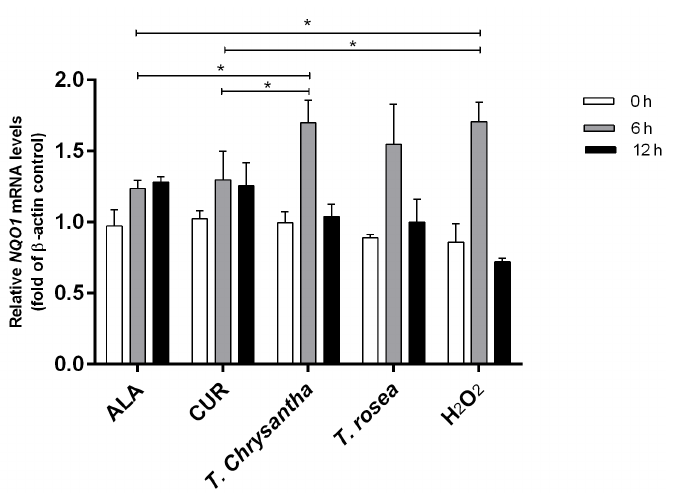
Figure 2. Relative NQO1 mRNA levels with 0, 6 and 12 hours post-exposure to 50 mM ALA, 15 mM CUR, ethyl acetate extracts from T. chrysantha (0.5 µg/mL) and T. rosea (1 µg/mL) and induction of oxidative stress with 0.6 mM H Alpha-lipoic acid; CUR: